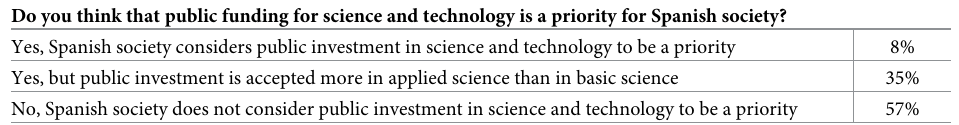
Table 4. Scientists’ views on the public prioritization of public investment in science and